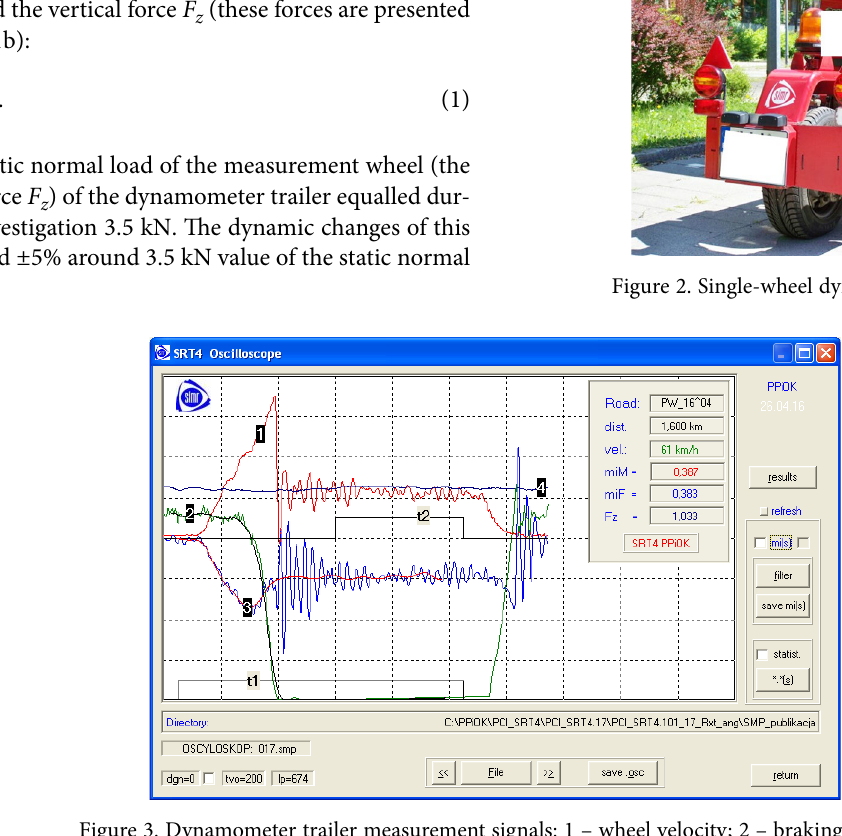
Figure 3. Dynamometer trailer measurement signals: 1 – wheel velocity; 2 – braking torque; 3 – wheel friction force; 4 – wheel normal